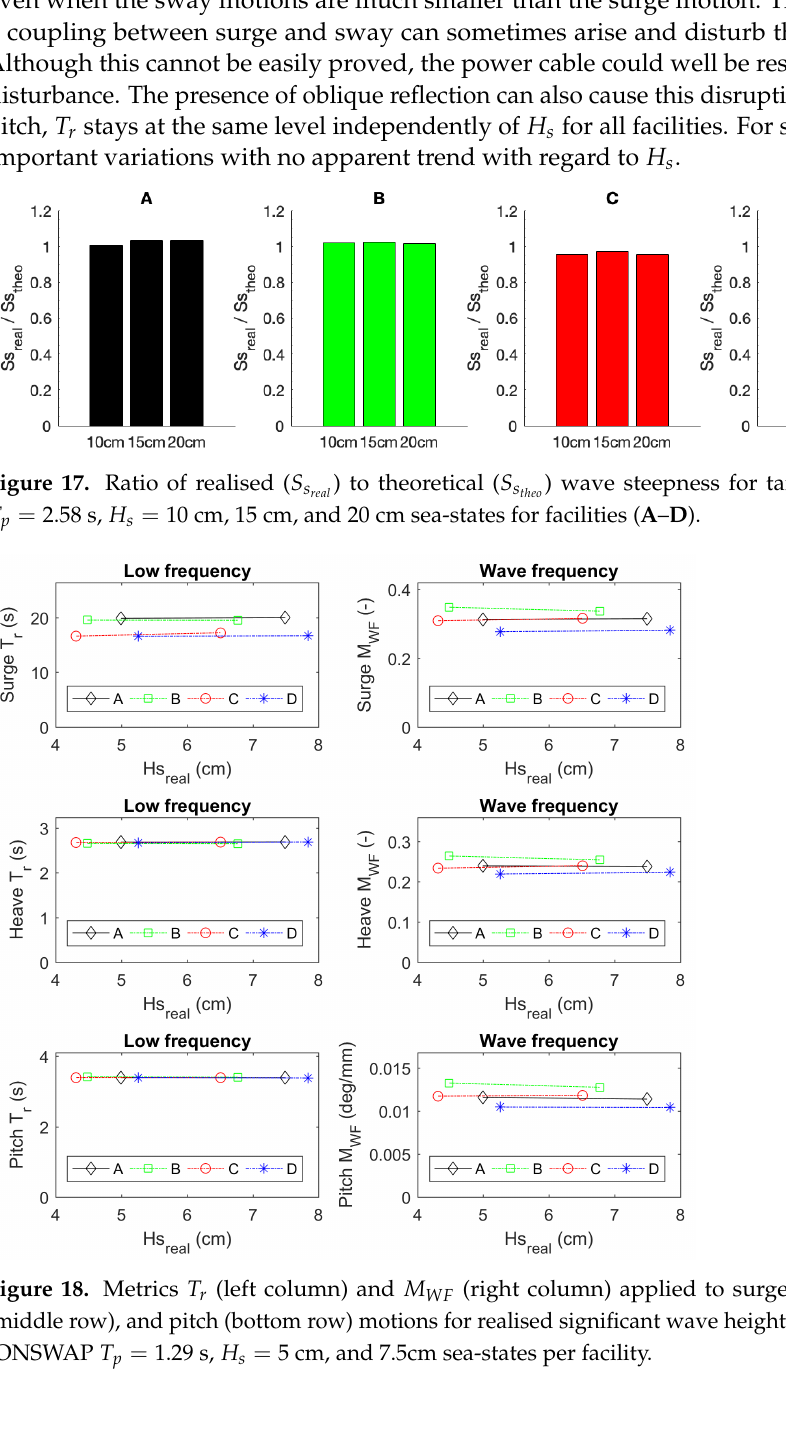
) with target real